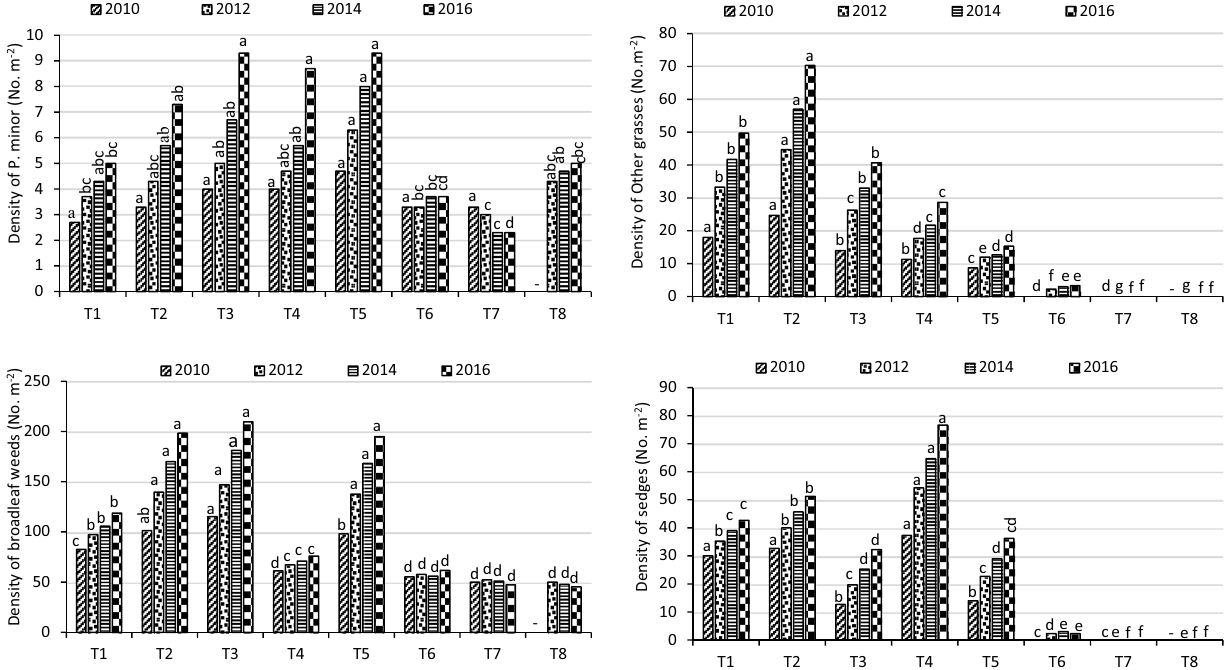
Fig. 1 Effect of different crop establishment methods on density of weeds in rice under the rice–wheat cropping system (alternate years). The bars of a season with similar letters did not differ